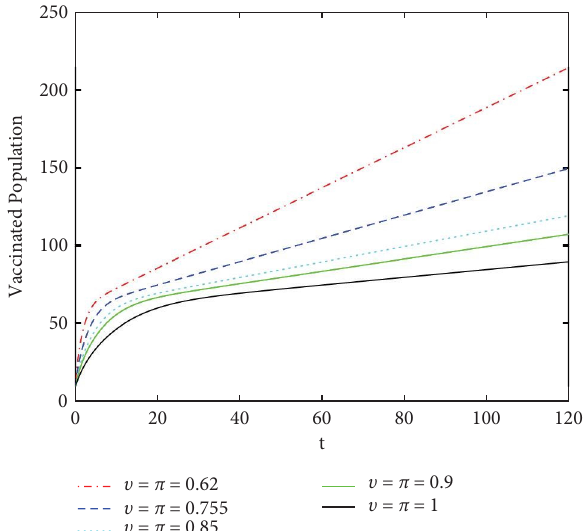
Figure 24: Te dynamics of vaccinated human population for various fractal-fractional orders.